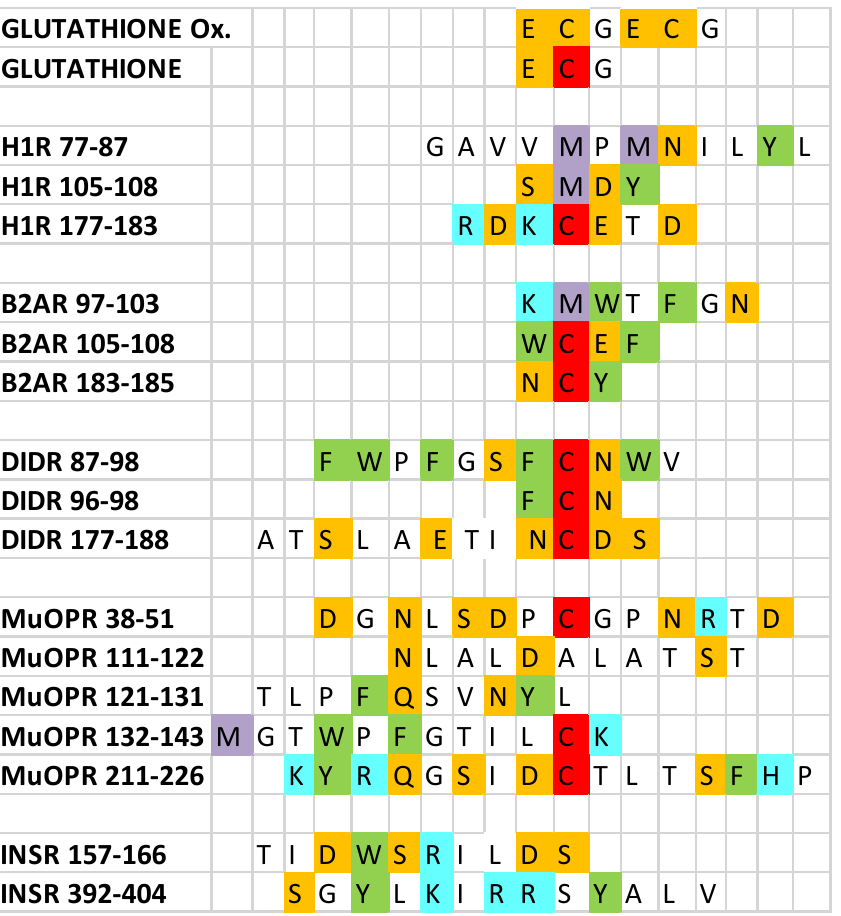
Figure 1. Sequences of the peptides utilized in the experiments reported here. Ox = oxidized; H1R = histamine 1 receptor; B2AR = beta 2 adrenergic receptor; D1DR = dopamine 1 receptor; muOPR = mu opioid receptor; INSR = insulin receptor. Amino acids are indicated by their one-letter abbreviations and are colored according to their charge similarities: blue = positively charged; orange = negatively charged; green = aromatic; white = neutral; red = cysteine; purple = methionine. Note that the cysteines in oxidized glutathione are colored orange because they are involved in a disulfide bond rather than being free cysteines (red).